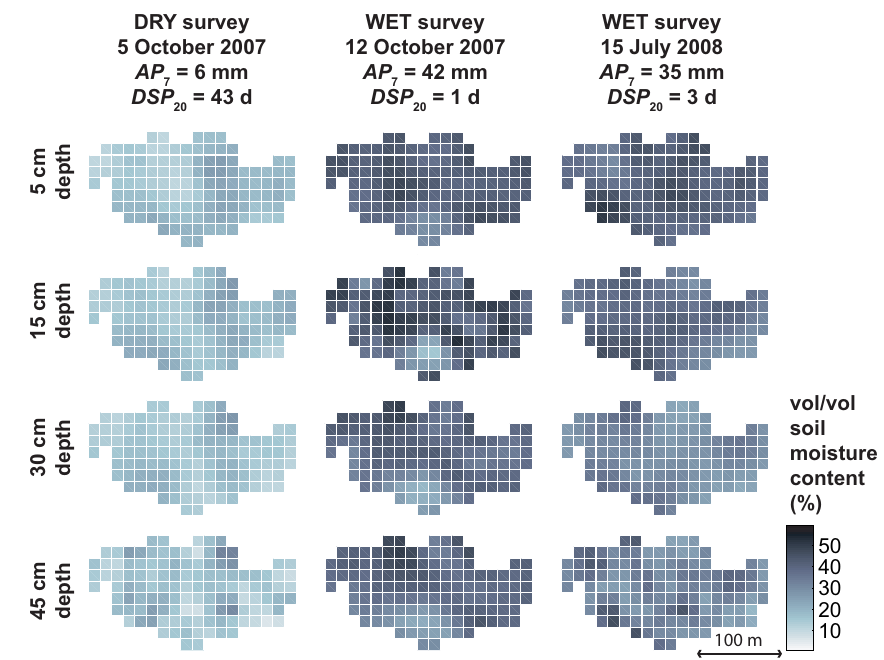
Fig. 2. Sample soil moisture maps obtained after three contrasted surveys in the Hermine catchment.